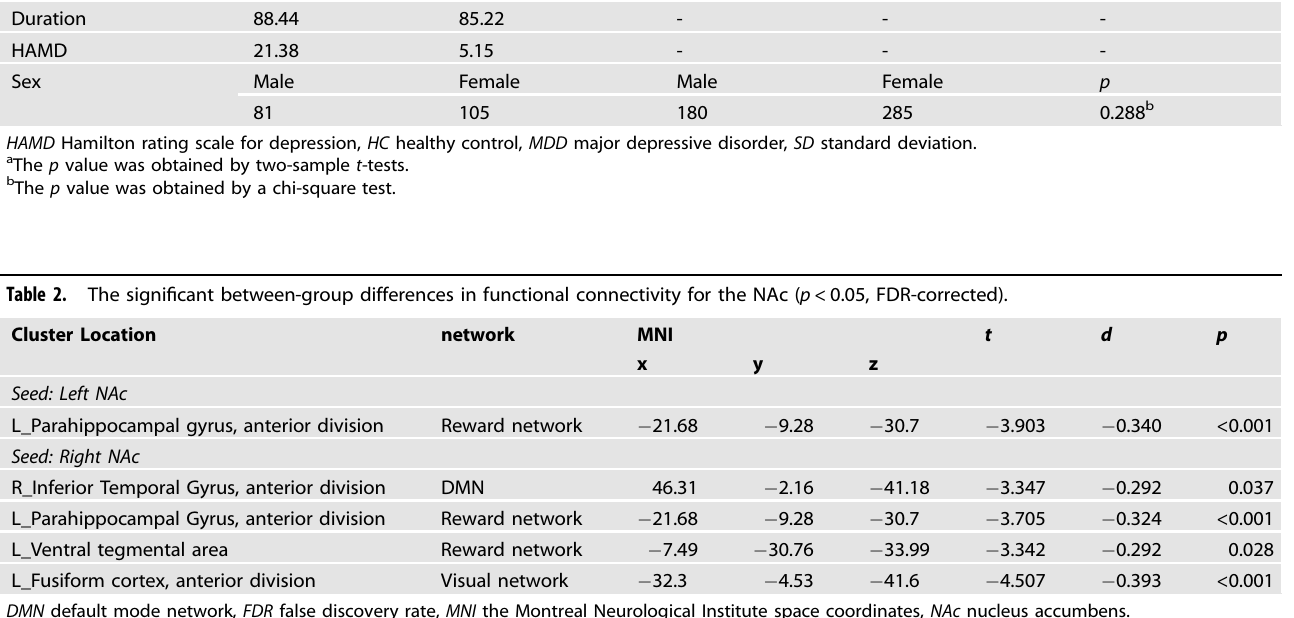
Table 1. Demographic and clinical characteristics of the participants included in the analysis.